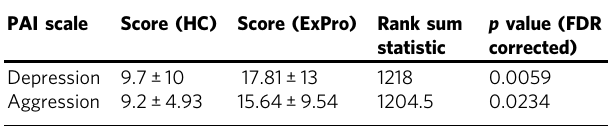
Table 1 PAI Depression and Aggression subscale scores for HC and ExPro